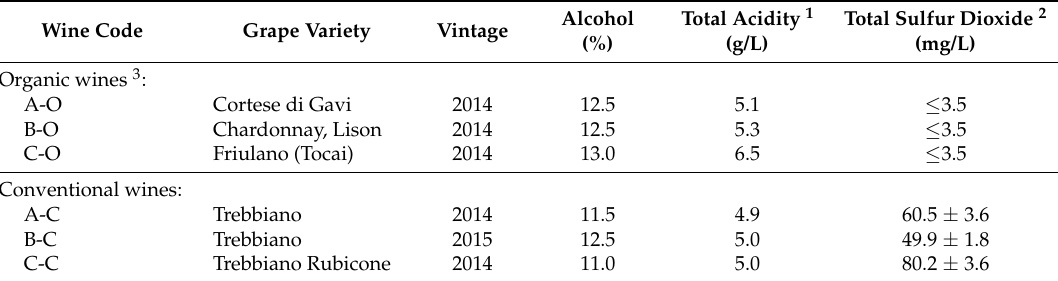
Table 1. Characteristics of the organic and conventional white